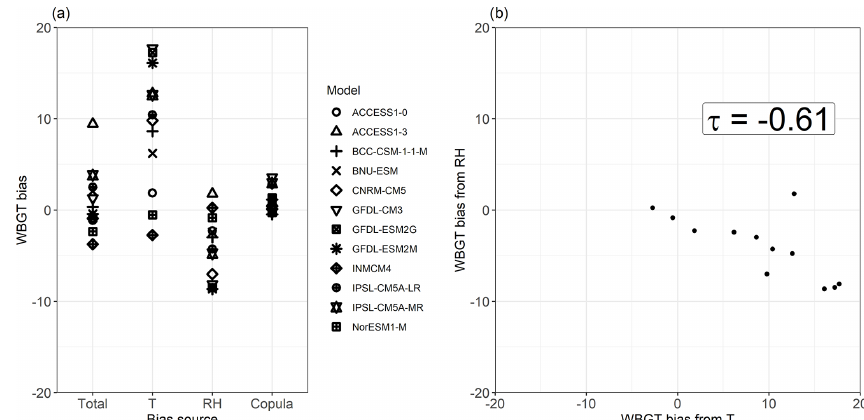
Figure 8. Spread of mean total bias in the 95th quantile (Q95) of WBGT and its contribution from T , RH, and their copula for individual CMIP5 models (a) , and a scatter plot of the T and RH contributions to Q95 WBGT bias, with their respective Kendall rank correlation coefficient ( p value < 0.001). Shown are results for a grid point in Brazil (Amazonia, 5 ◦ S and 56.5 ◦ W). Bias was calculated as (CMIP5 or transformation minus ERA-Interim). Equal axes are used in panel (b) to highlight the differences in spread between both bias